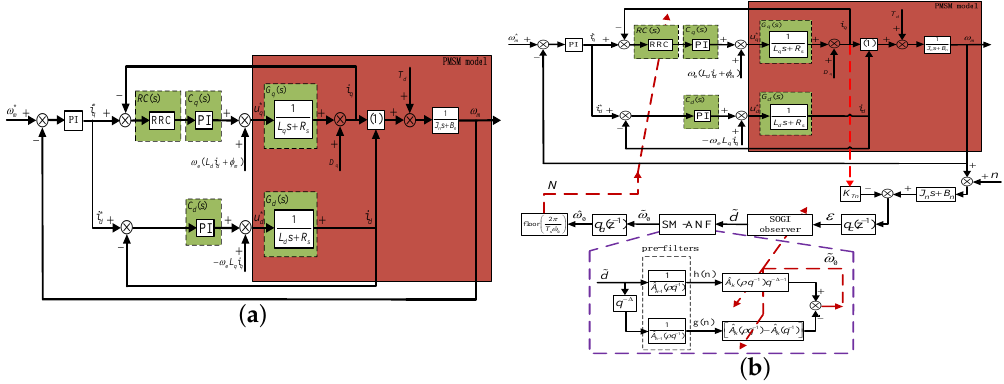
Figure 7. Block diagram of FOC with RRC: ( a ) general; ( b ) adaptive.